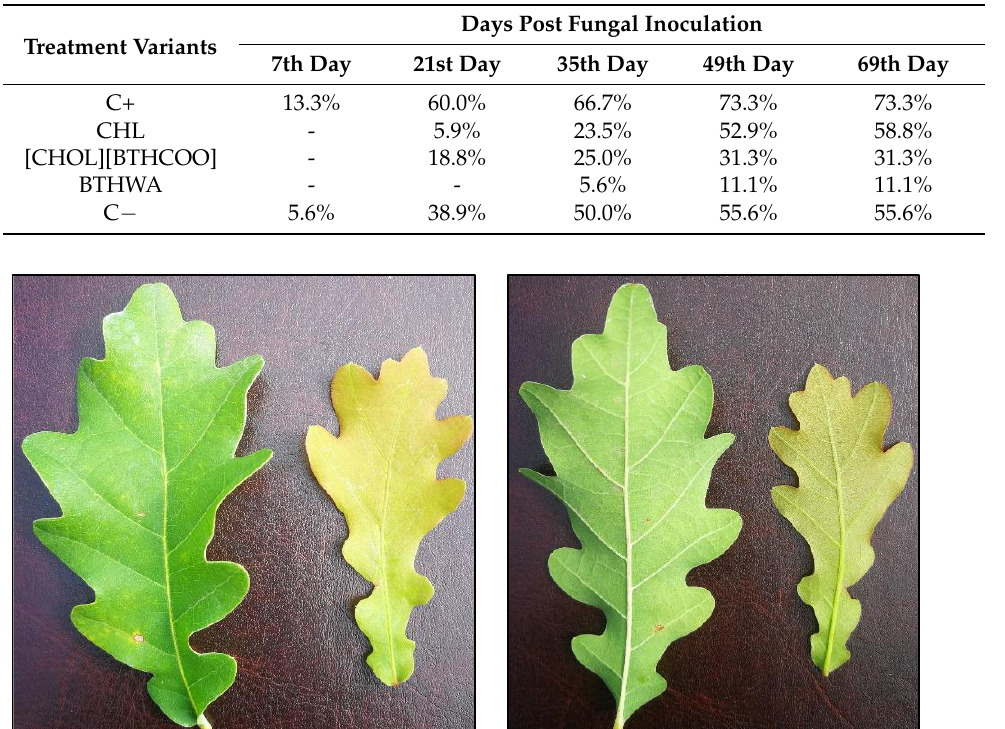
Table 1. The percentage of seedlings with visible symptoms of powdery mildew on the following days after inoculation.